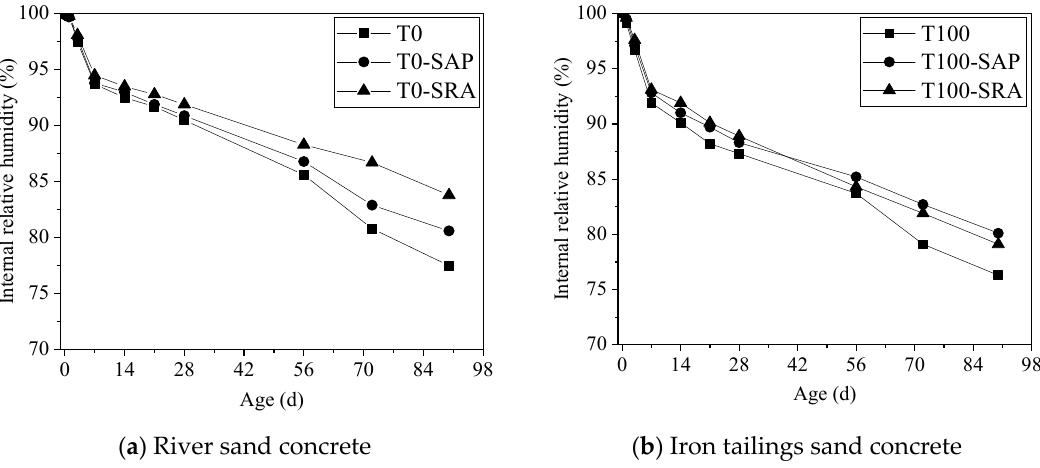
Figure 10. Development of internal RH of different concrete under autogenous shrinkage.